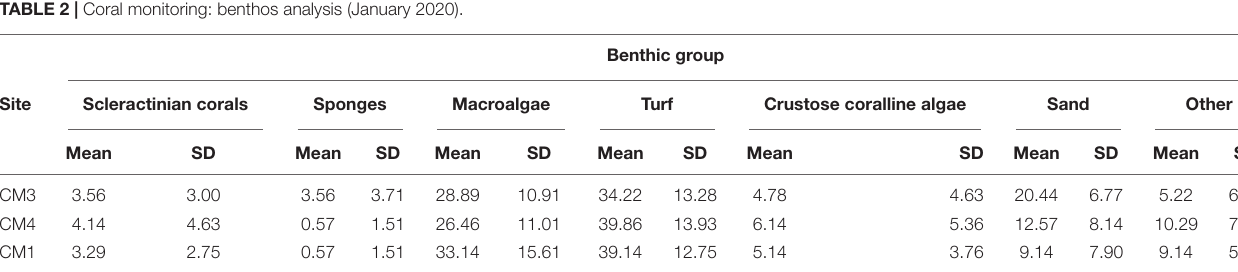
TABLE 2 | Coral monitoring: benthos analysis (January 2020).